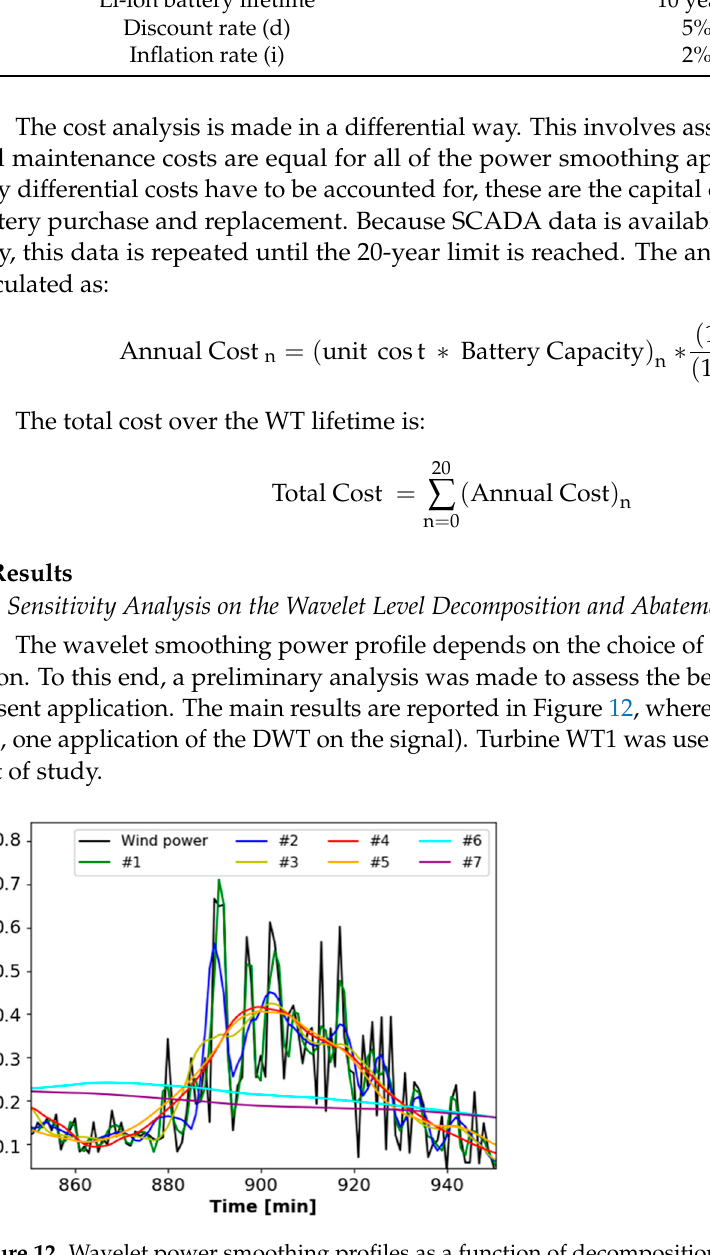
Figure 12. Wavelet power smoothing profiles as a function of decomposition